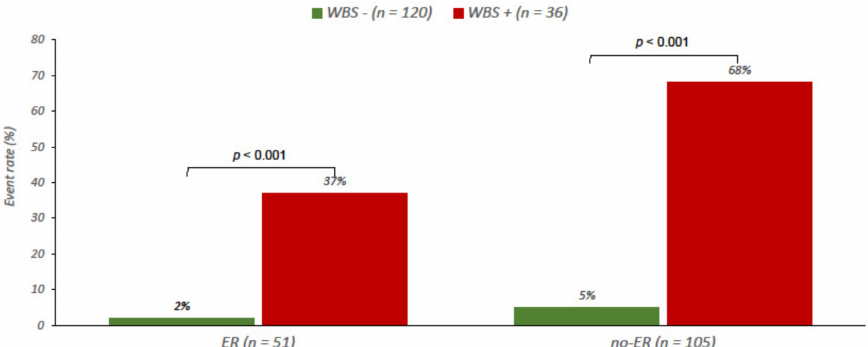
Figure 4. Event rate in patients at intermediate/high ATA risk and pre-therapy Tg ≥ 10 ng/mL, according to 12-months response to therapy by Tg and US and diagnostic WBS findings. ER (excellent response), WBS (whole body